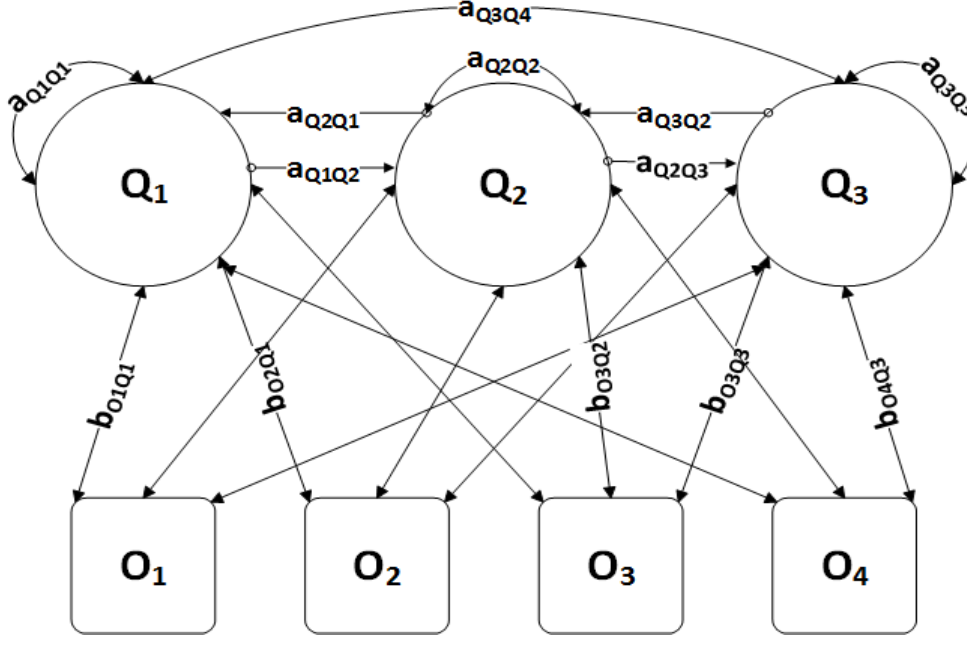
Figure 2. Example of Graphical Representation of Hidden Markov Model (HMM).